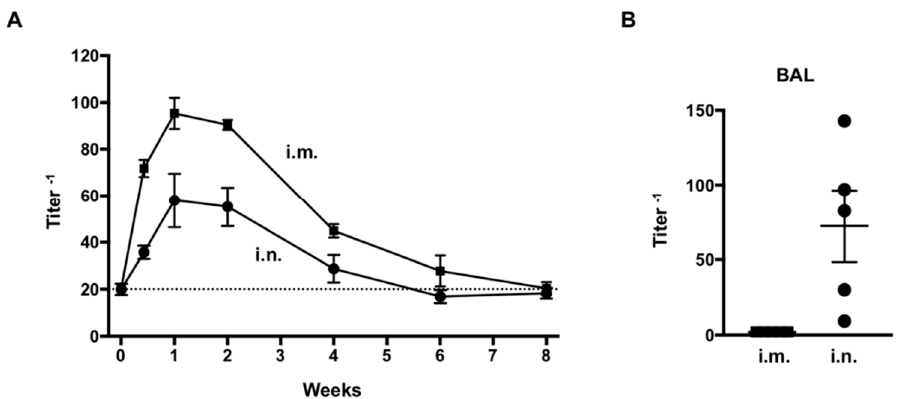
Figure 4. Assessment of anti-respiratory syncytial virus (anti-RSV) IgG expression in adult mice. ( A ) Kinetics of anti-RSV IgG in the serum following intranasal (i.n.) or intramuscular (i.m.) administration of AdC7 α RSV (5 x 10 10 pu). Titers were measured by ELISA. Data are shown as mean ± SEM of 4 mice per group. ( B ) Anti-RSV IgG in the bronchoalveolar lavage (BAL) 1 week following administration of AdC7 α RSV (5 x 10 10 pu). Titers were measured by ELISA. Data are shown with mean ± SEM.